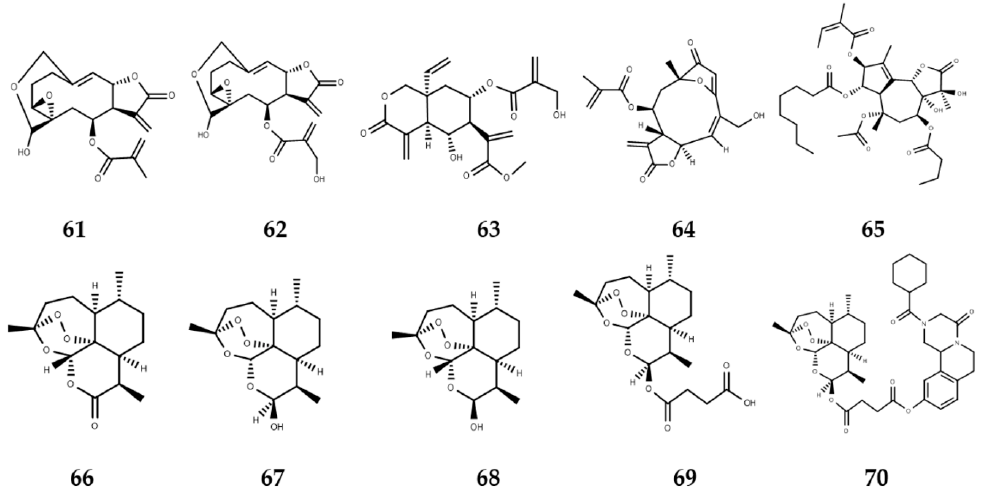
Figure 3. Sesquiterpene lactones with biological activity against NTDs.